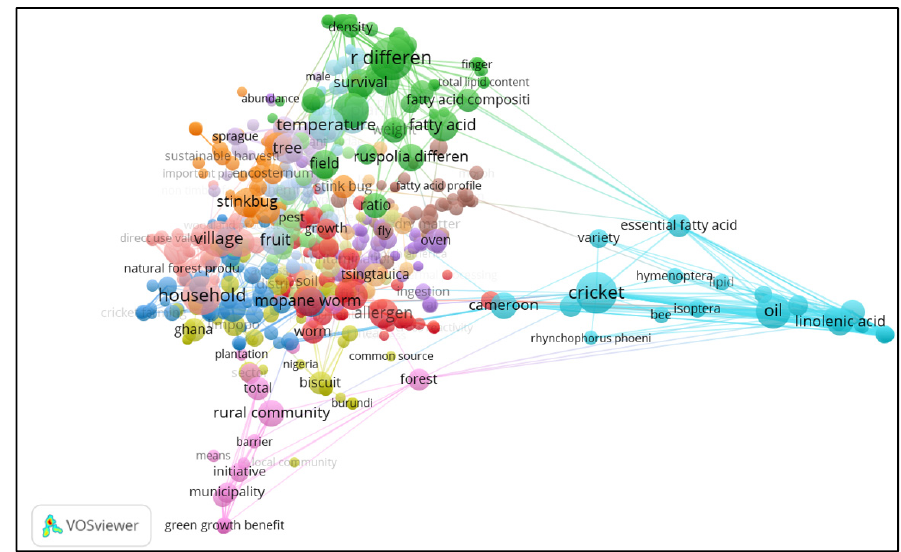
Figure 5. Output of term co-occurrence on edible insect studies in Africa.